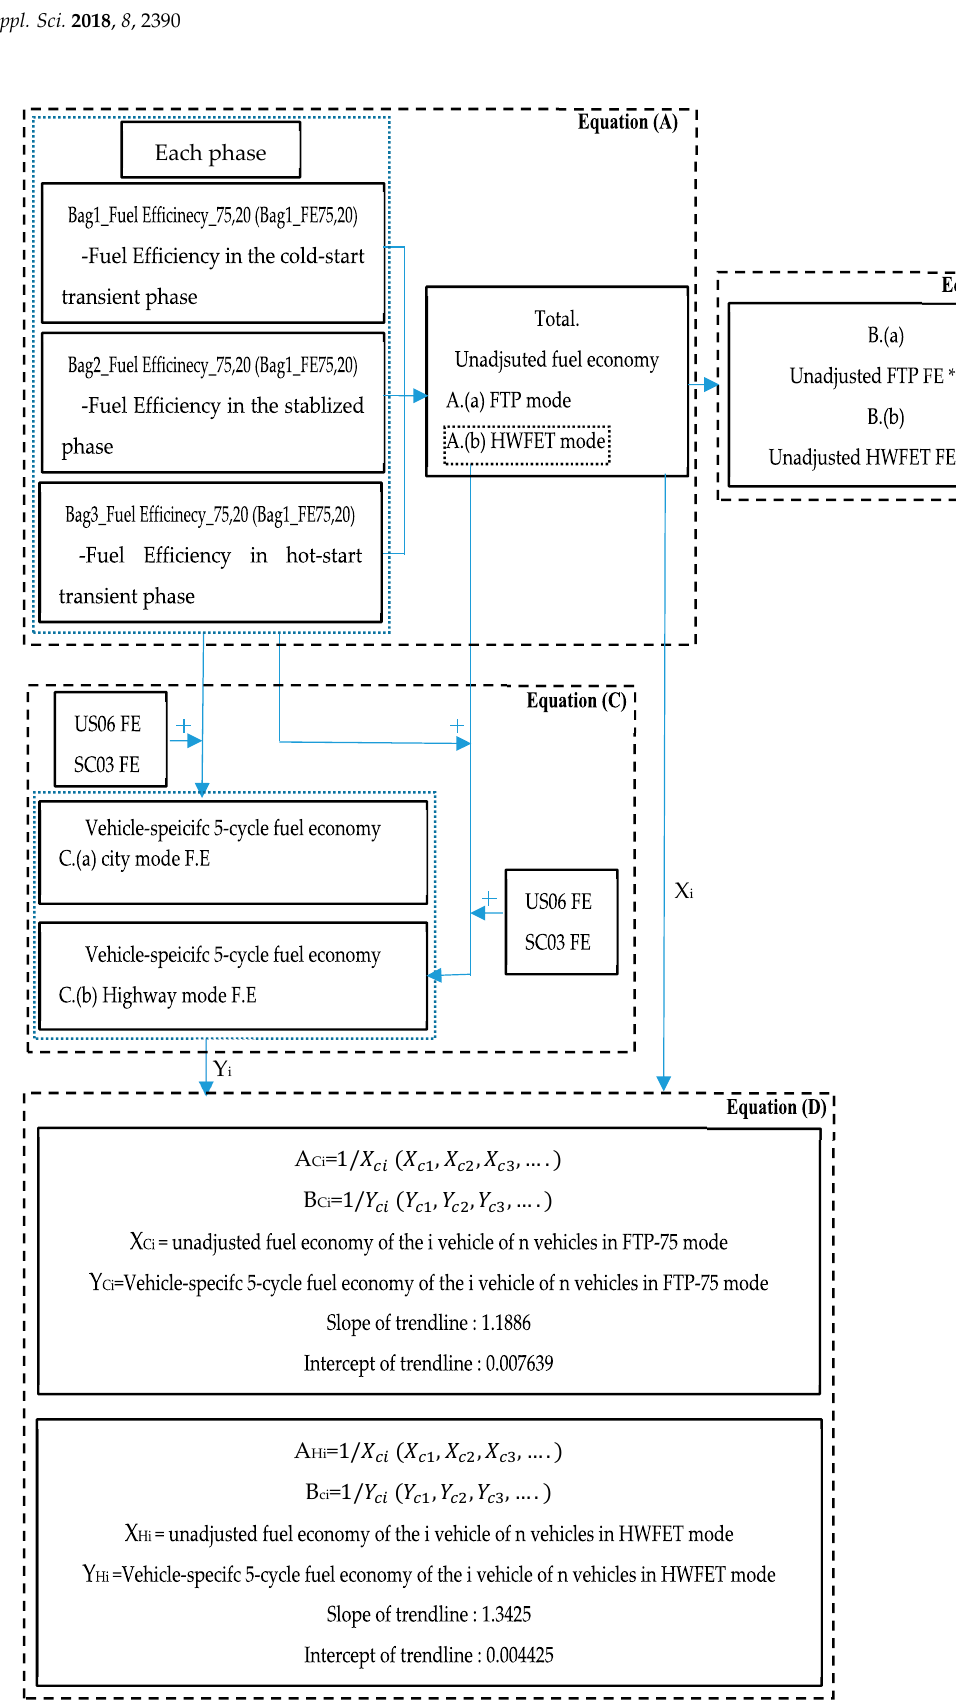
Figure 4. Flow chart of fuel consumption equations.